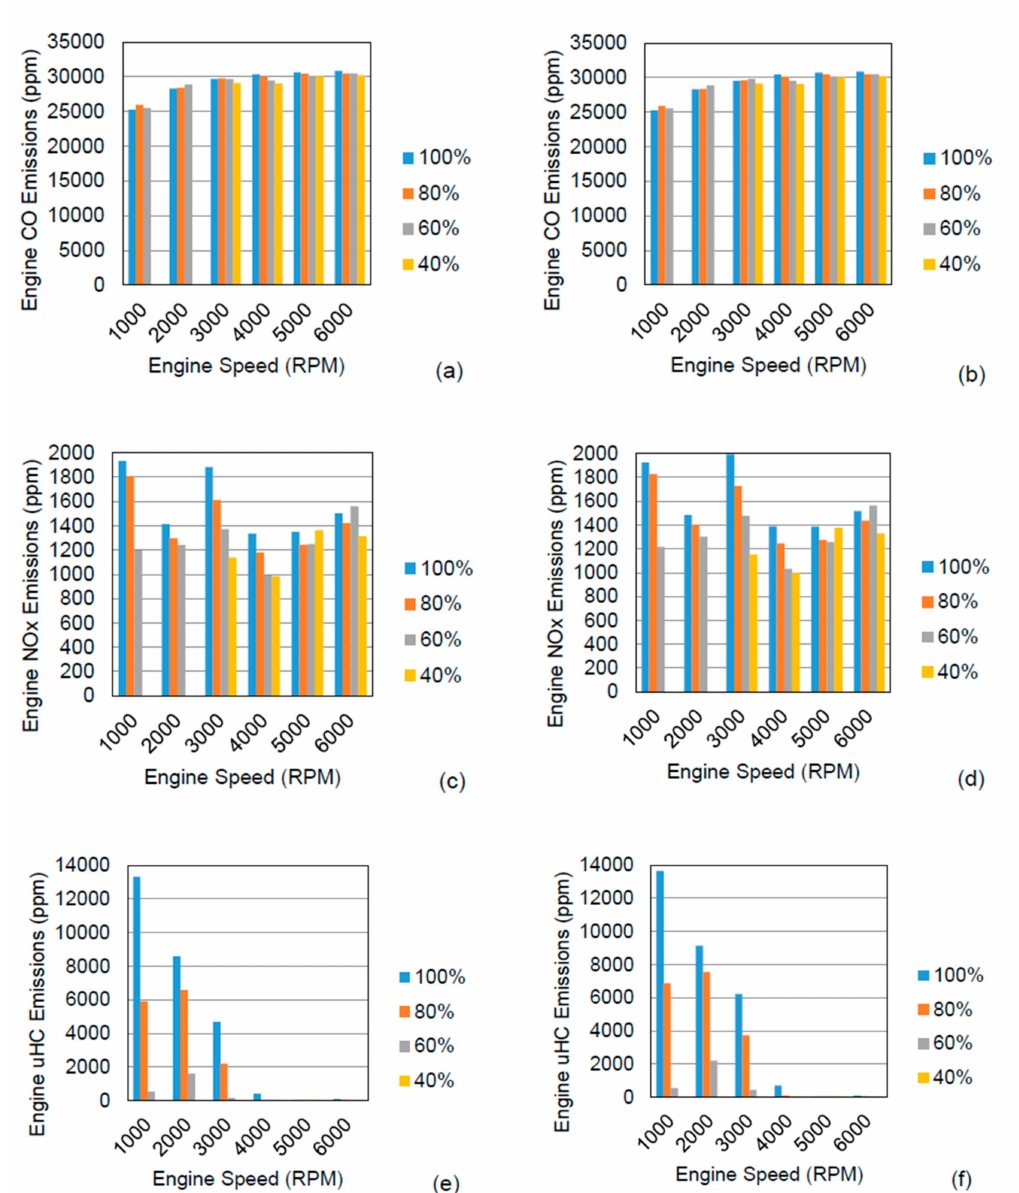
Figure 30. Comparison of engine cylinder emissions between radial ( a , c , e ) and axial turbines ( b , d , f ) at di ff erent engine operating